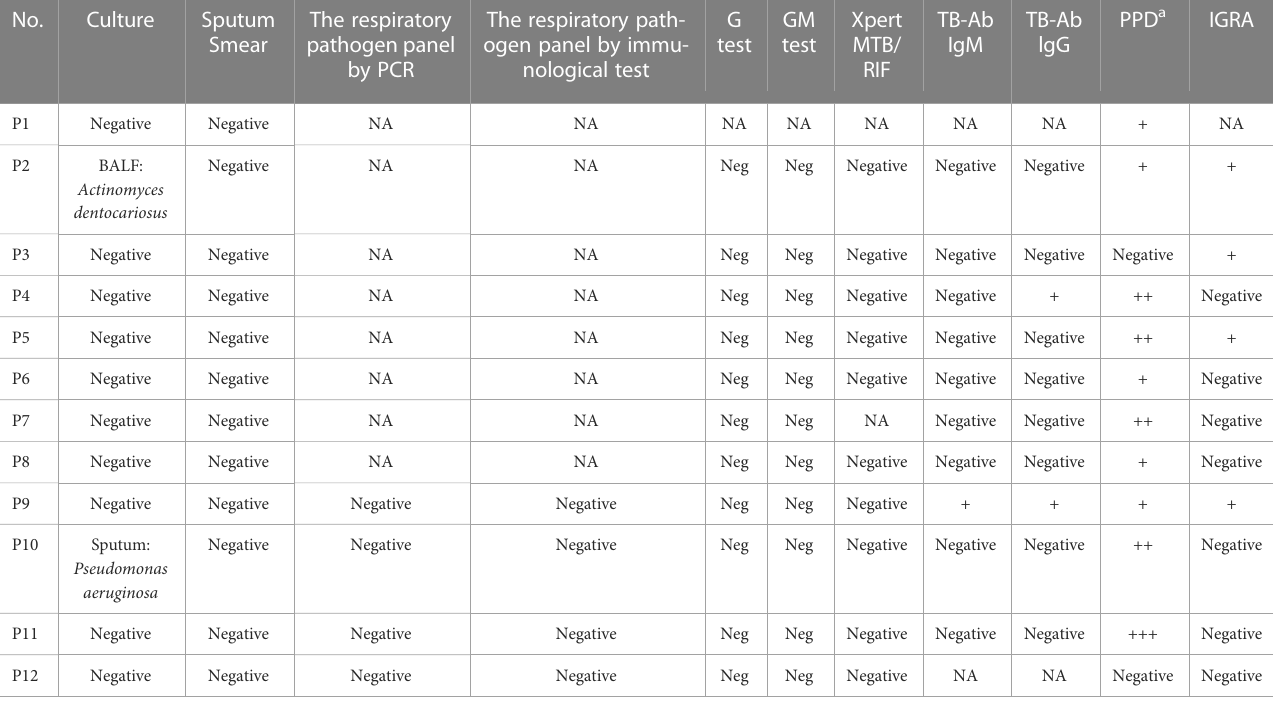
TABLE 4 Conventional microbiological